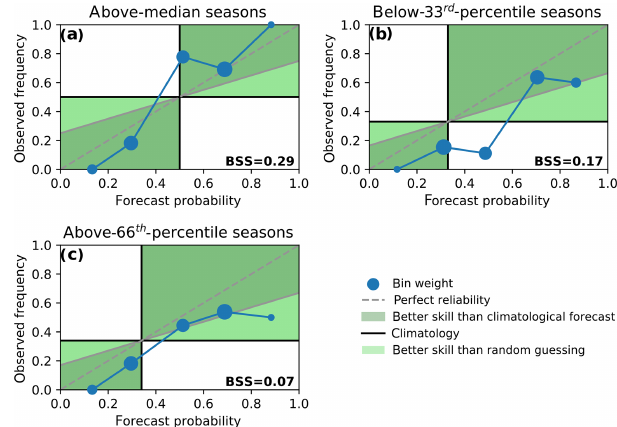
Figure 6. Reliability diagrams for a logistic regression model on May precursors and for three types of seasonal activities: above median (a) , below 33rd percentile (b) , above 66th percentile (c) . Dots show the mean hindcasted probability versus the observed fre- quency of a (seasonal) event. The size of the dots indicates the rel- ative number of data points that contributed to a bin. A perfectly reliable forecast would lie on the diagonal (dashed grey line). Dots within the dark-green area contribute to a forecast skill improve- ment compared to the climatology while dots within the light-green area contribute to a forecast skill improvement compared to random guessing. The Brier skill score (BSS) is indicated in the lower right corner of each